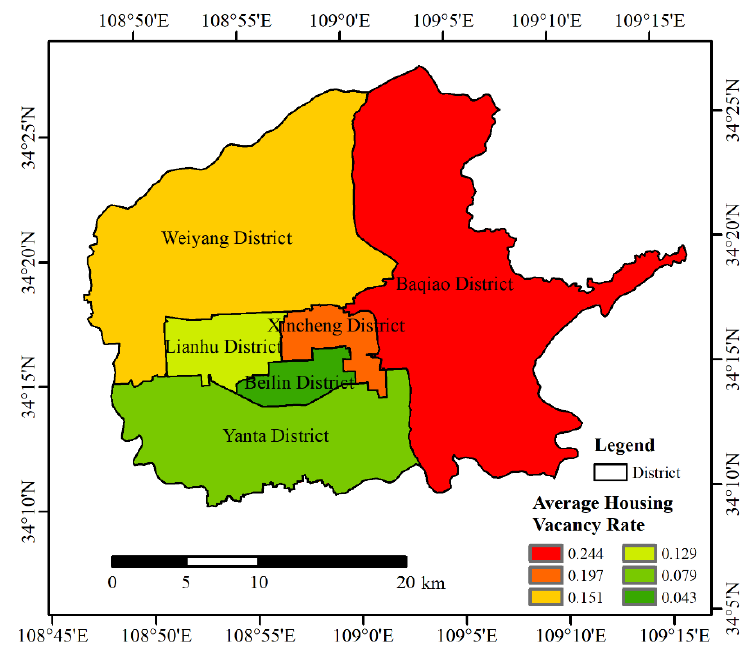
Figure 9. House vacancy rates at the district scale.